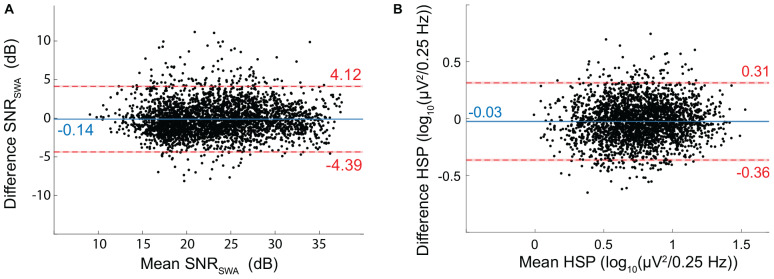
Bland-Altman for EEG Signal quality metrics. (A) SNR of SWA (SNRSWA) agreement between EEGDrDr and EEGPgPg. (B) Height of the spindle peak (HSP) agreement between EEGDrDr and EEGPgPg. The mean (x-axis) and difference (y-axis) of EEGDrDr and EEGPgPg were calculated for each epoch. Dots, solid lines, dashed lines, red bars, and blue bars can be interpreted as in Figure 7.